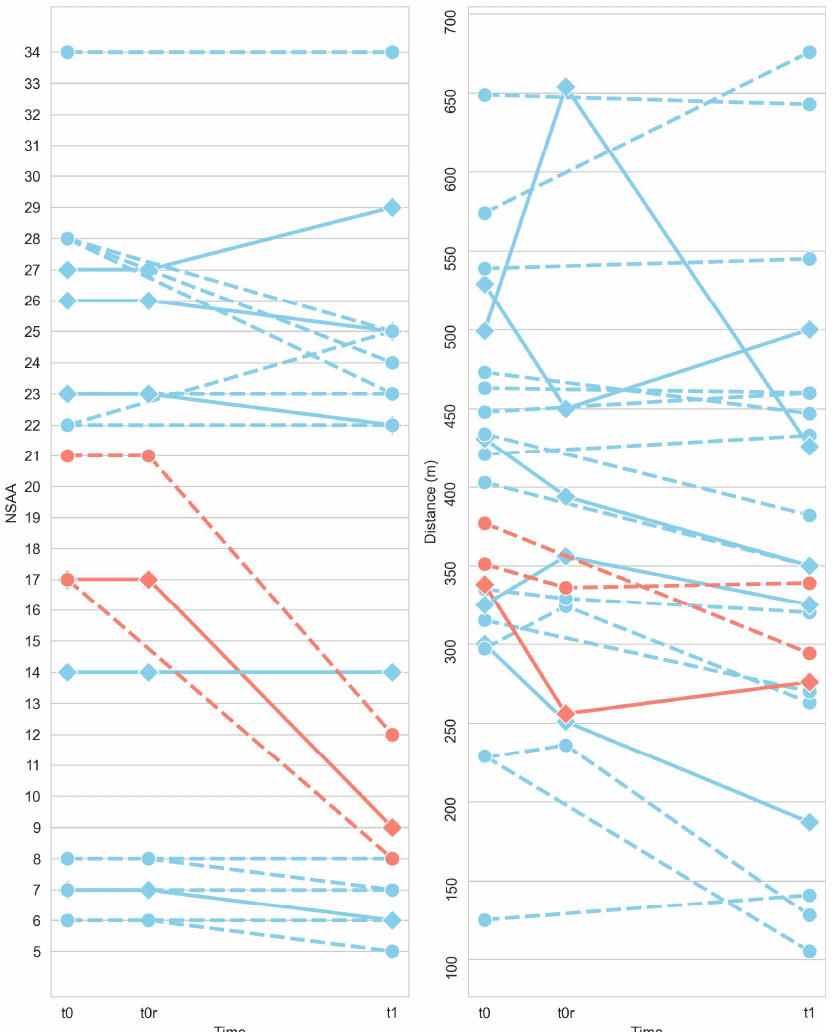
Figure 2. NSAA ( left ) and 6MWD ( right ) individual evolution for DMD (pathological) subjects between initial session (t0), the retest session (t0r), and the final session (6 months later, t1). Subjects colored in pink showed an abrupt decline in NSAA score between t0 and t1. Subjects with a solid line achieved a difference in distance between t0 and t0r greater than 30 m.